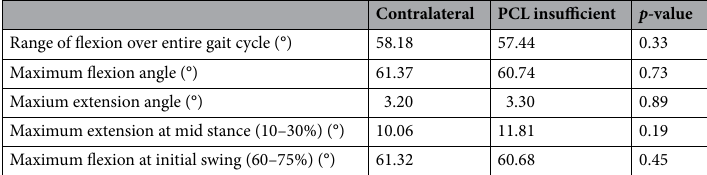
Table 2. Analysis of knee flexion–extension angles during level